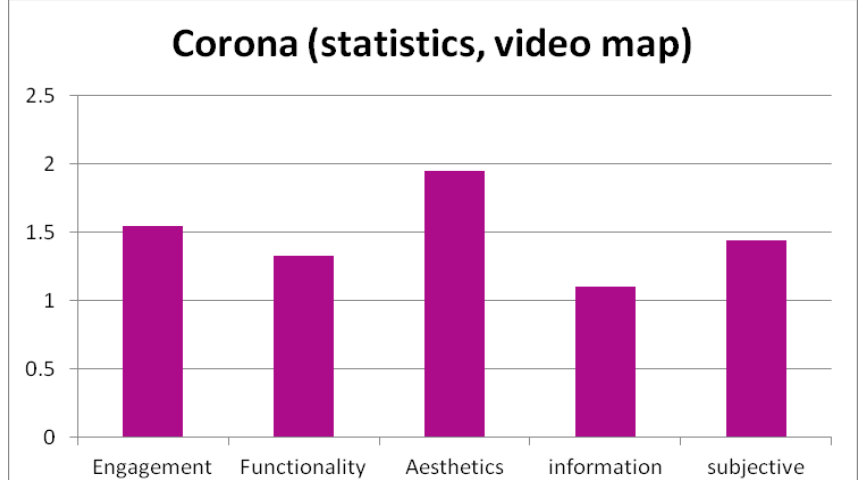
Fig14. The evaluation of indicators in Corona (statistics, video map) according to MARS